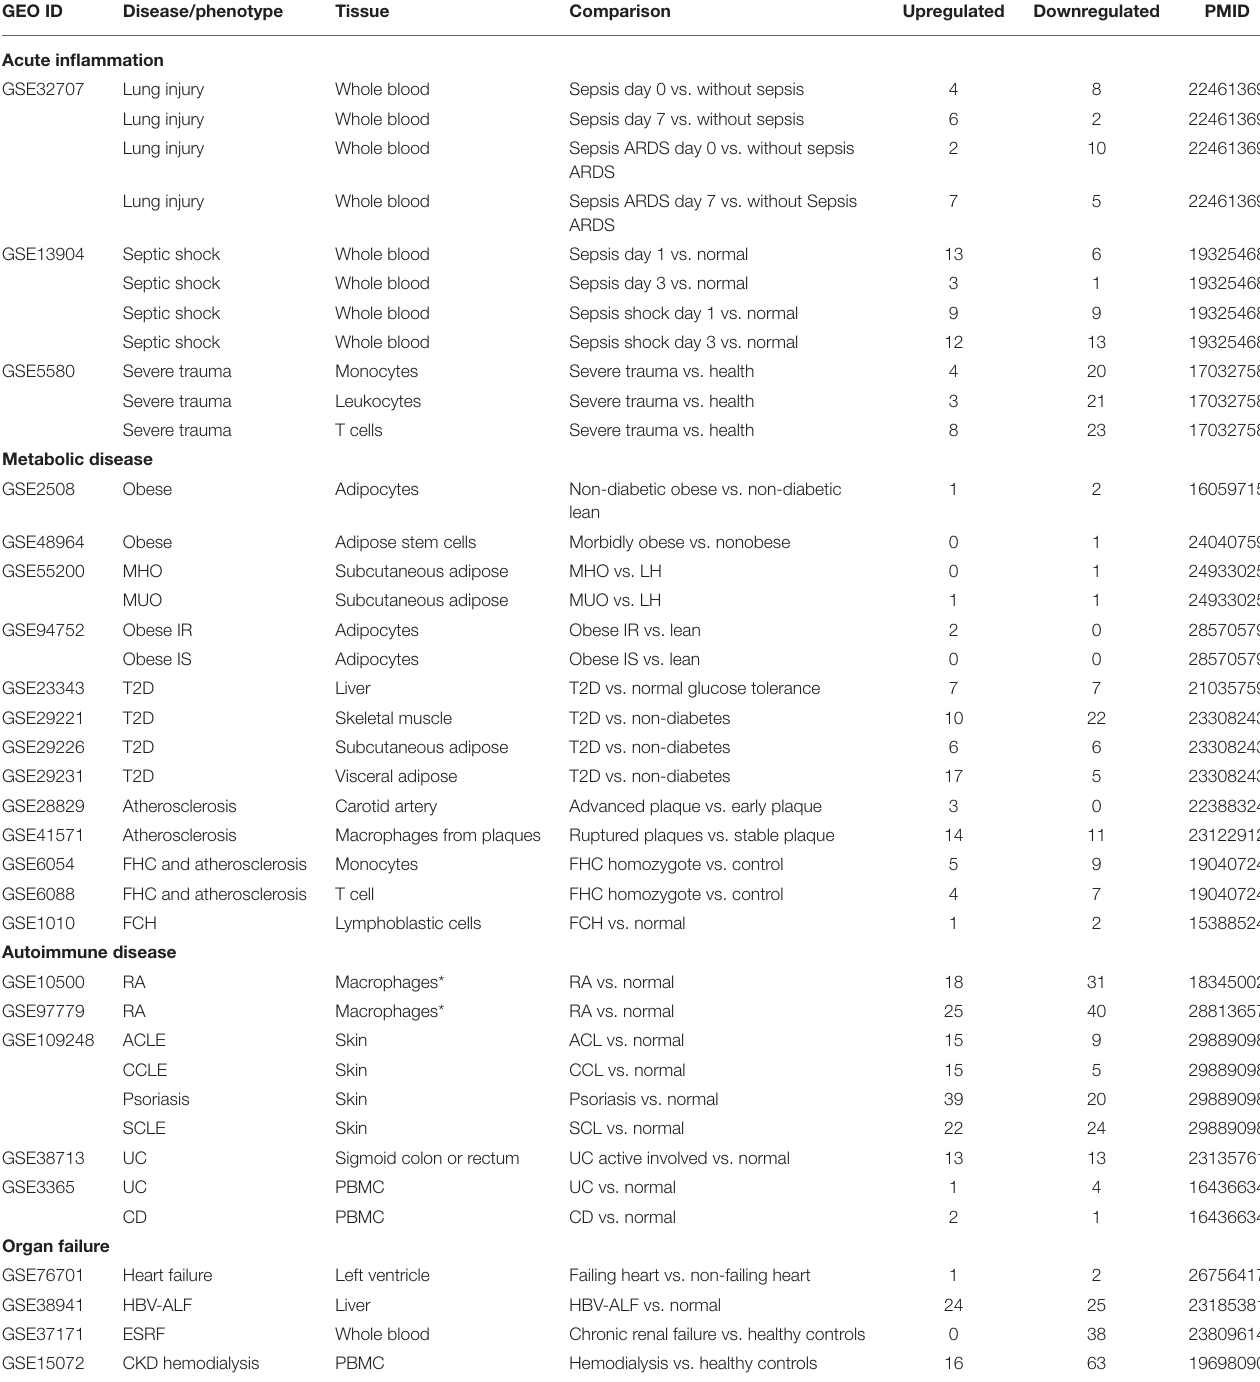
TABLE 2 | Twenty-five microarray datasets including acute inflammations, metabolic diseases, autoimmune diseases, and organ failure diseases in the National Institutes of Health (NIH)–National Center for Biotechnology Information (NCBI)–Gene Expression Omnibus (GEO) dataset database (https://www.ncbi.nlm.nih.gov/gds/) were collected to analyze the expression changes of organelle crosstalk regulators